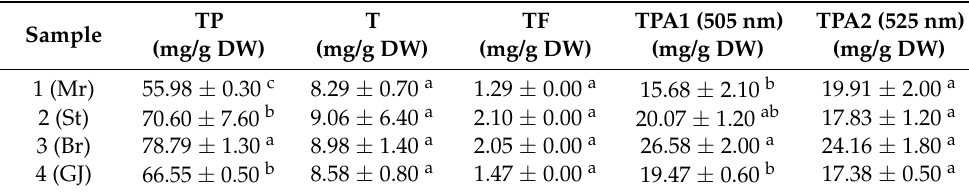
Table 4. Contents of total polyphenols (TP), total tannins (T), total flavonoids (TF), and total phenolic acids (TPA) in V. austriaca ssp. jacquinii .